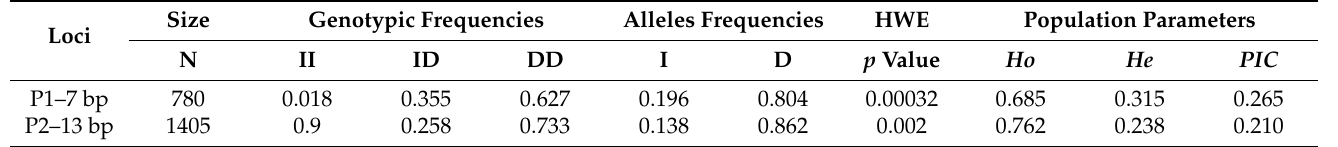
Table 1. Genetic parameters of two indel loci within AKAP12 gene in Shaanbei white cashmere goats. Size Genotypic Frequencies Alleles Frequencies HWE Population Parameters Loci